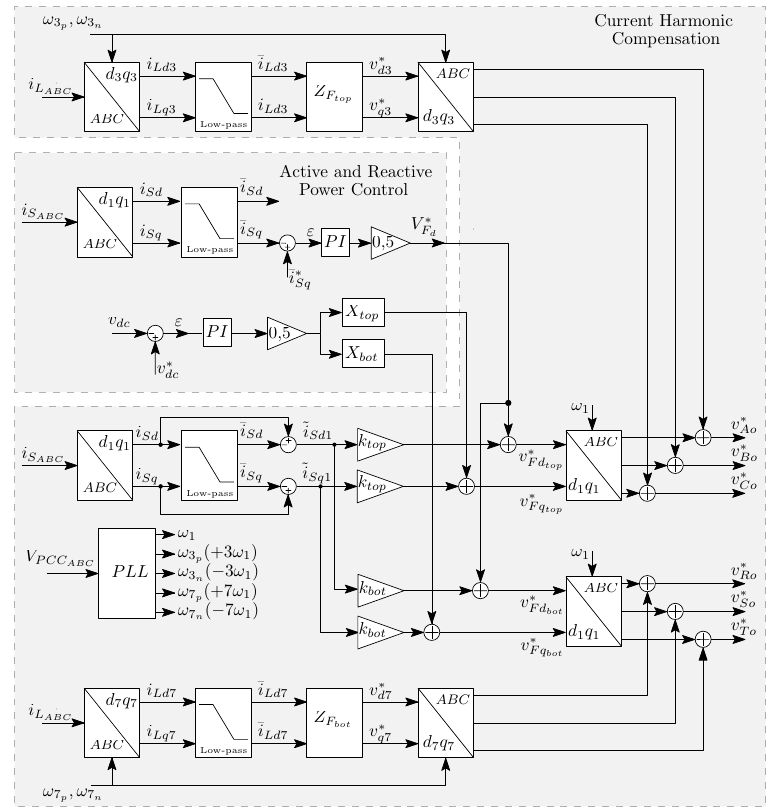
Figure 4. Control diagram of the DHPF-NSI with fundamental and harmonic components